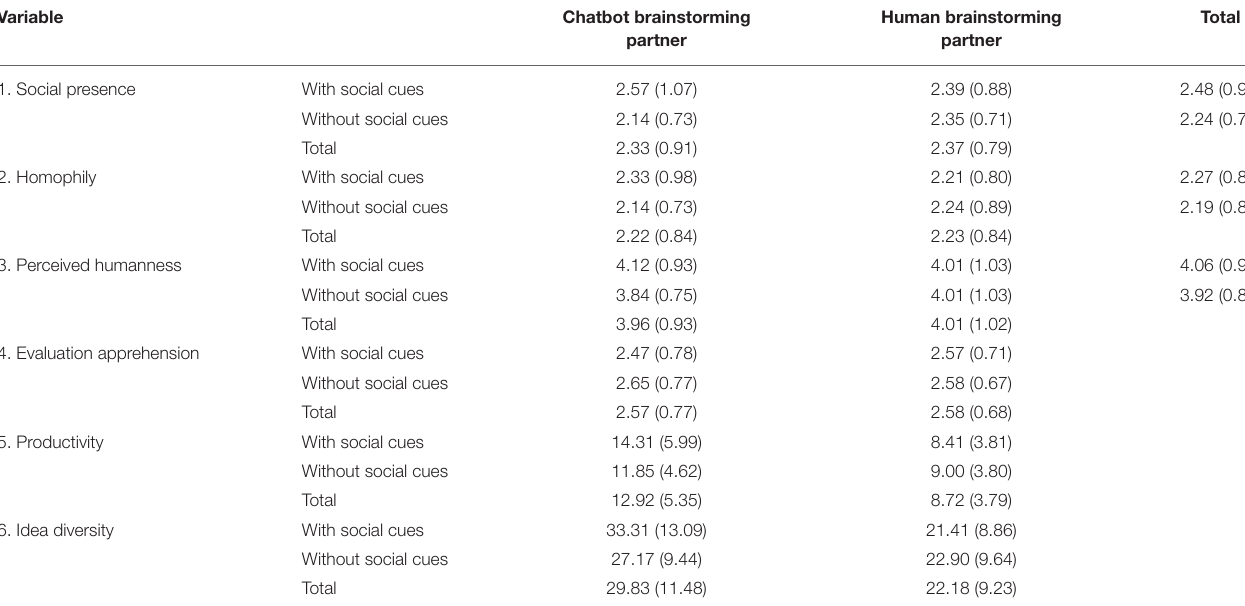
TABLE 2 | Means and standard deviations (between parentheses). Variable